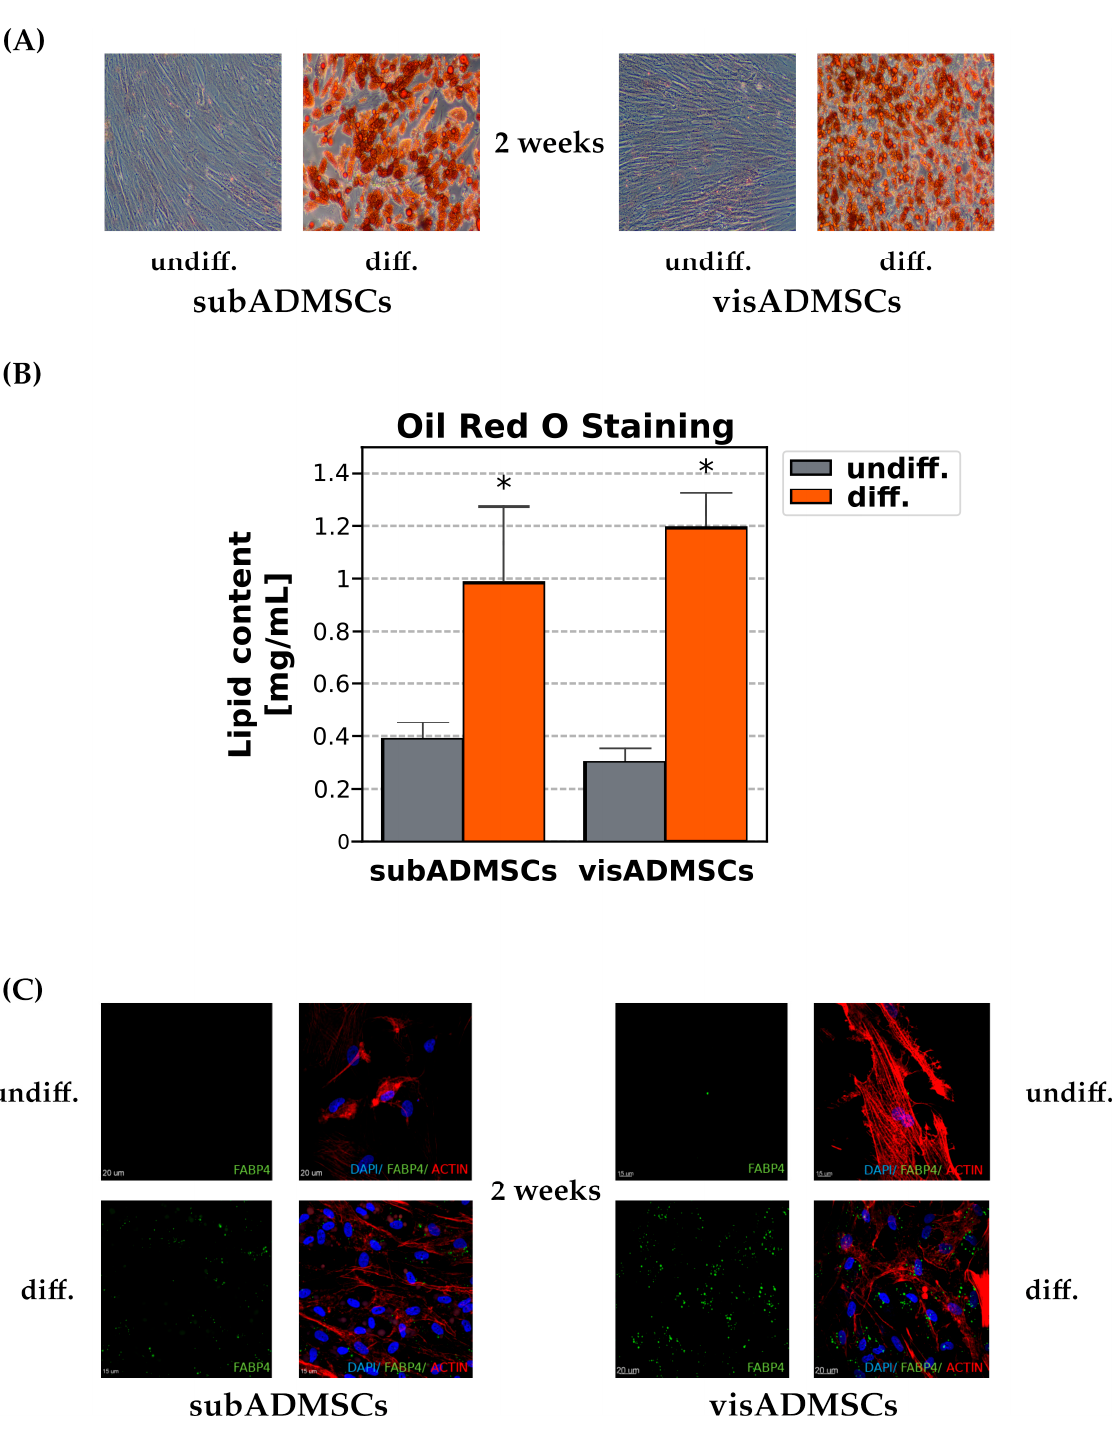
Figure 4. Adipocyte differentiation of subcutaneous and visceral ADMSCs. ( A ) Morphology of undifferentiated and adipogenically differentiated ADMSCs. Mature adipocytes were observed after 14 days of adipogenic differentiation from sub- and visADMSCs. Lipid vacuole presence was verified by Oil Red O staining. Magnification 10×. ( B ) Quantification of lipid content in the undifferentiated and differentiated ADMSCs. Bars and whiskers represent the mean and SD, respectively. Number of patients equals four (measurements taken in triplicate). * significantly different from undifferentiated cells, p < 0.05. ( C ) Intracellular localisation of FABP4 (green), nuclei (blue) and actin filaments (red) were visualised by fluorescence microscopy. Scale bar represents 15 and 20 µm.